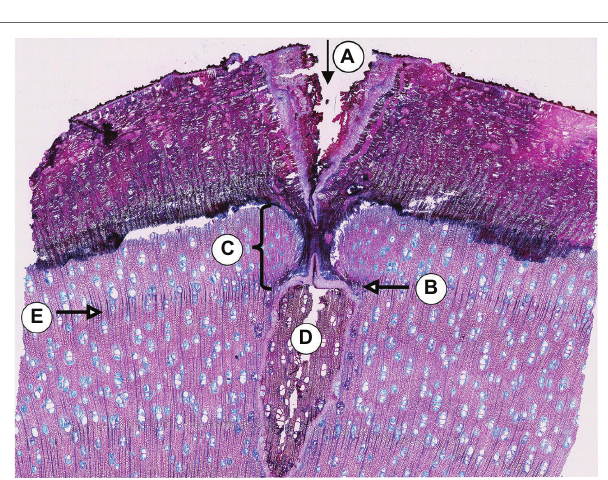
FIGURE 3 | Micro-section indicating the pinning area of the third pinning event in tree no. 1 (April 11th, 2019). A: Pinning hole in the bark; B: Callous tissue formed as a reaction of the irritated cambial cells surrounding the pinning hole; C: Amount of xylem produced after pinning until the felling date; D: Pinning hole in the xylem that was already formed at the time of pinning; E: Ring boundary of the ring formed before